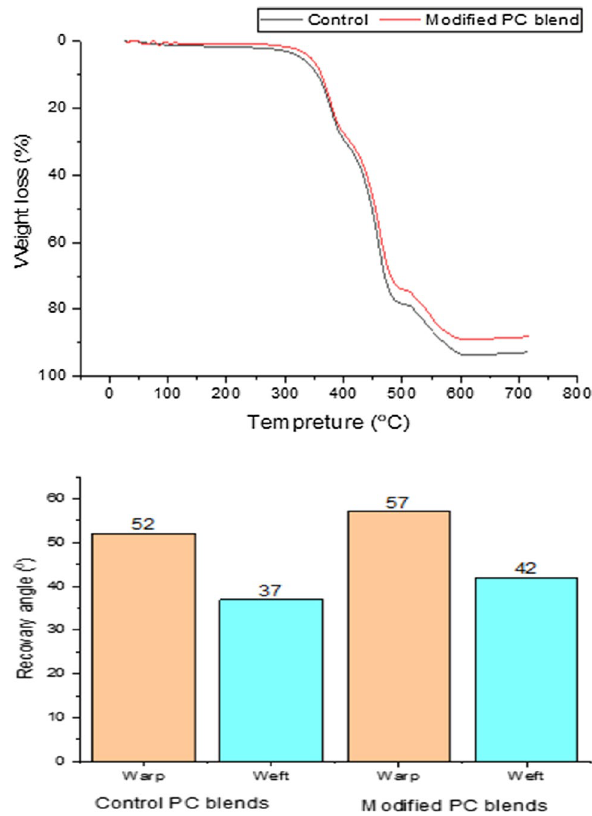
Fig. 8 Comparison of crease resistance of control and modified PC